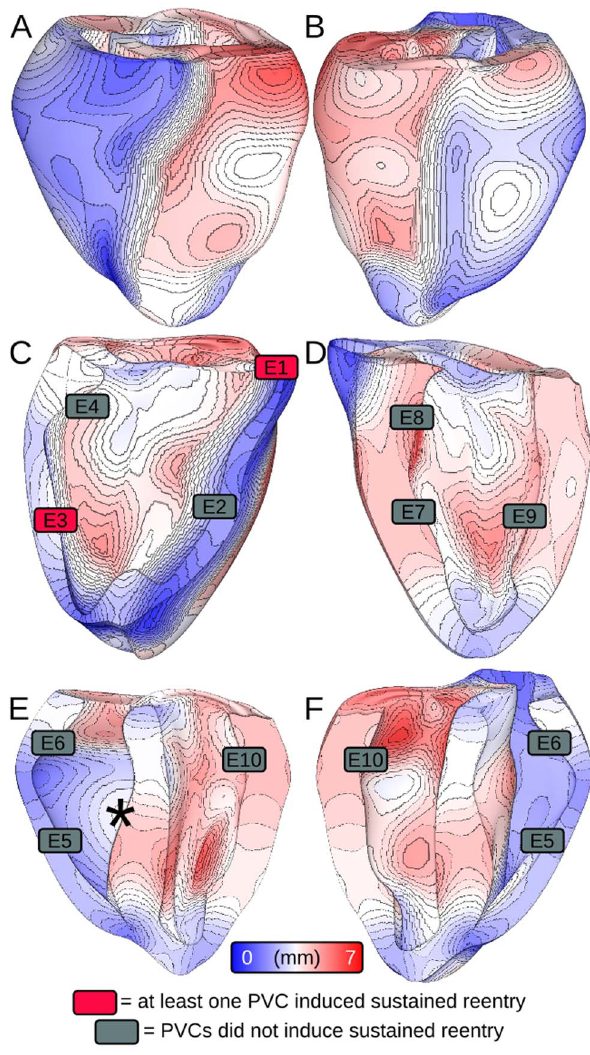
Figure 4. Maps of ventricular WT. (A–B) Anterior and posterior views. (C–D) Cutaway views of right and left sides of ventricular septum. (E–F) Cutaway views of posterior and anterior endocardium. All 10 endocardial PVC initiation locations are shown. Rectangle color indicates whether ectopic stimuli originating from that site induced sustained arrhythmia. Asterisk (in E) indicates a region of WT expansion in the RV free wall (see text for further detail). WT: wall thickness. doi:10.1371/journal.pone.0086947.g004 Fig. 4E. We also examined local WT values at RV sites from which PVCs never initiated sustained reentry. E4 was located in a relatively thick part of the RV ( < 3.5 mm), which explained why ectopic wavefronts emerging from that site always activated the LV free wall and septum. The explanation for lack of reentry induction by PVCs from E2 was less straightforward – like E3, E2 was located in a thin part of the RV ( < 1.5 mm), proximal to a thick part of the LV ( < 4.6 mm) on the other side of the anterioseptal RV insertion; however, the septal region near E2 was much thinner ( < 3.0 mm) than that near E3, which allowed ectopic activation from E2 to overcome slow conduction and activate the LV (see Fig. 3C).